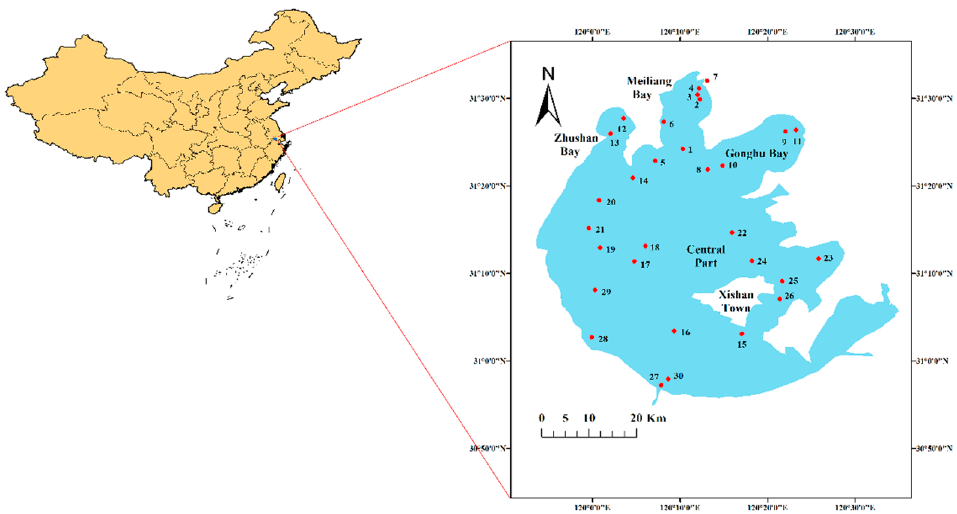
Figure 1. Map of sampling sites in Taihu Lake.